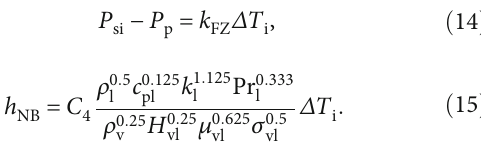
LFP by Equation (2).